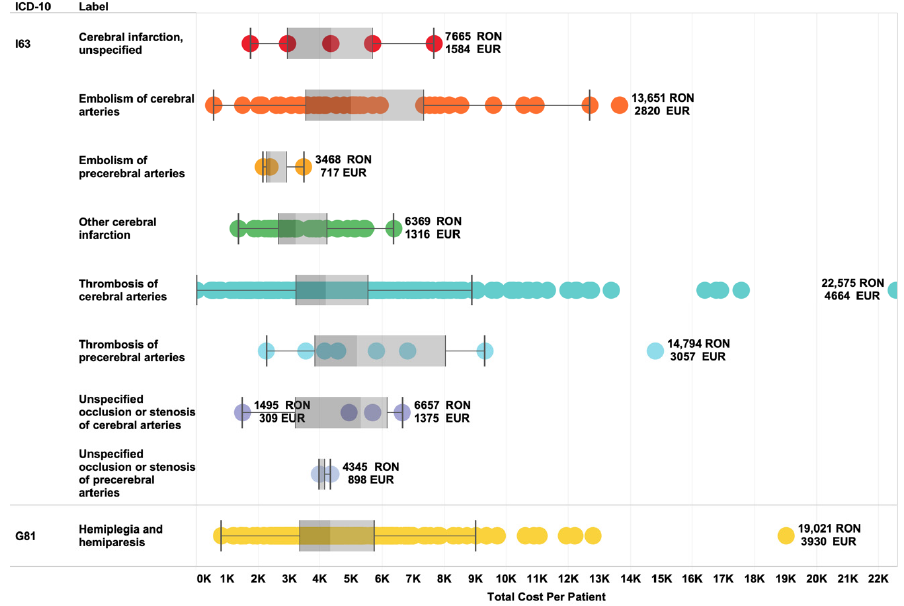
Figure 1. Distribution of average total cost per patient across ICD-10 diagnosis categories. The difference between average total costs and coding distribution across wards can be observed in Figure 2.